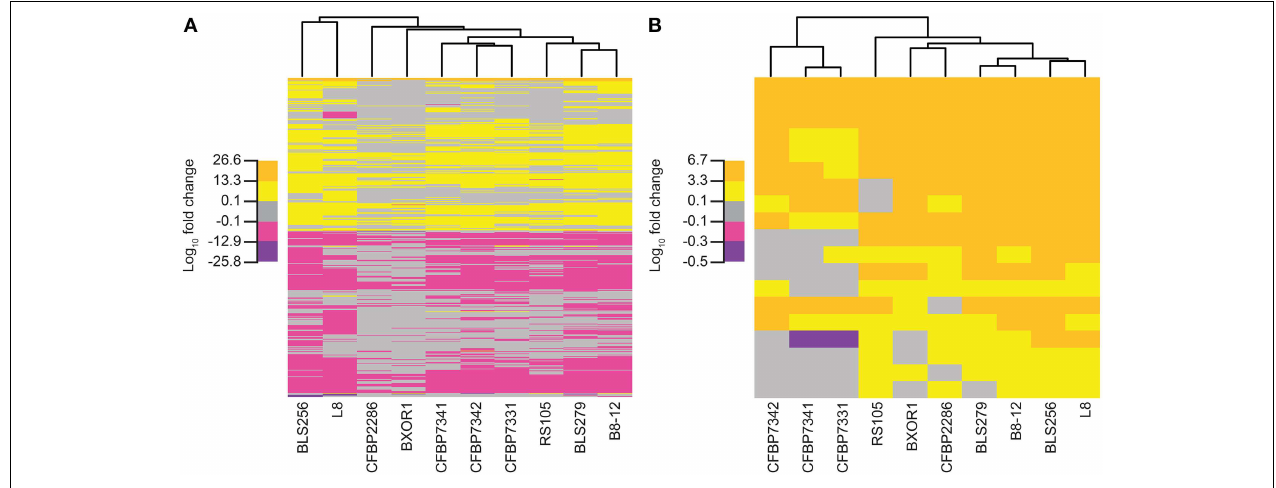
BLS256 TAL effectors. Each tree was generated by complete linkage clustering based on the Euclidean distance between vectors of log 10 fold change. For each tree, five subdivisions of the log 10 fold change values observed in the data for that tree were used: the minimum, half of the minimum, the maximum, and half of the